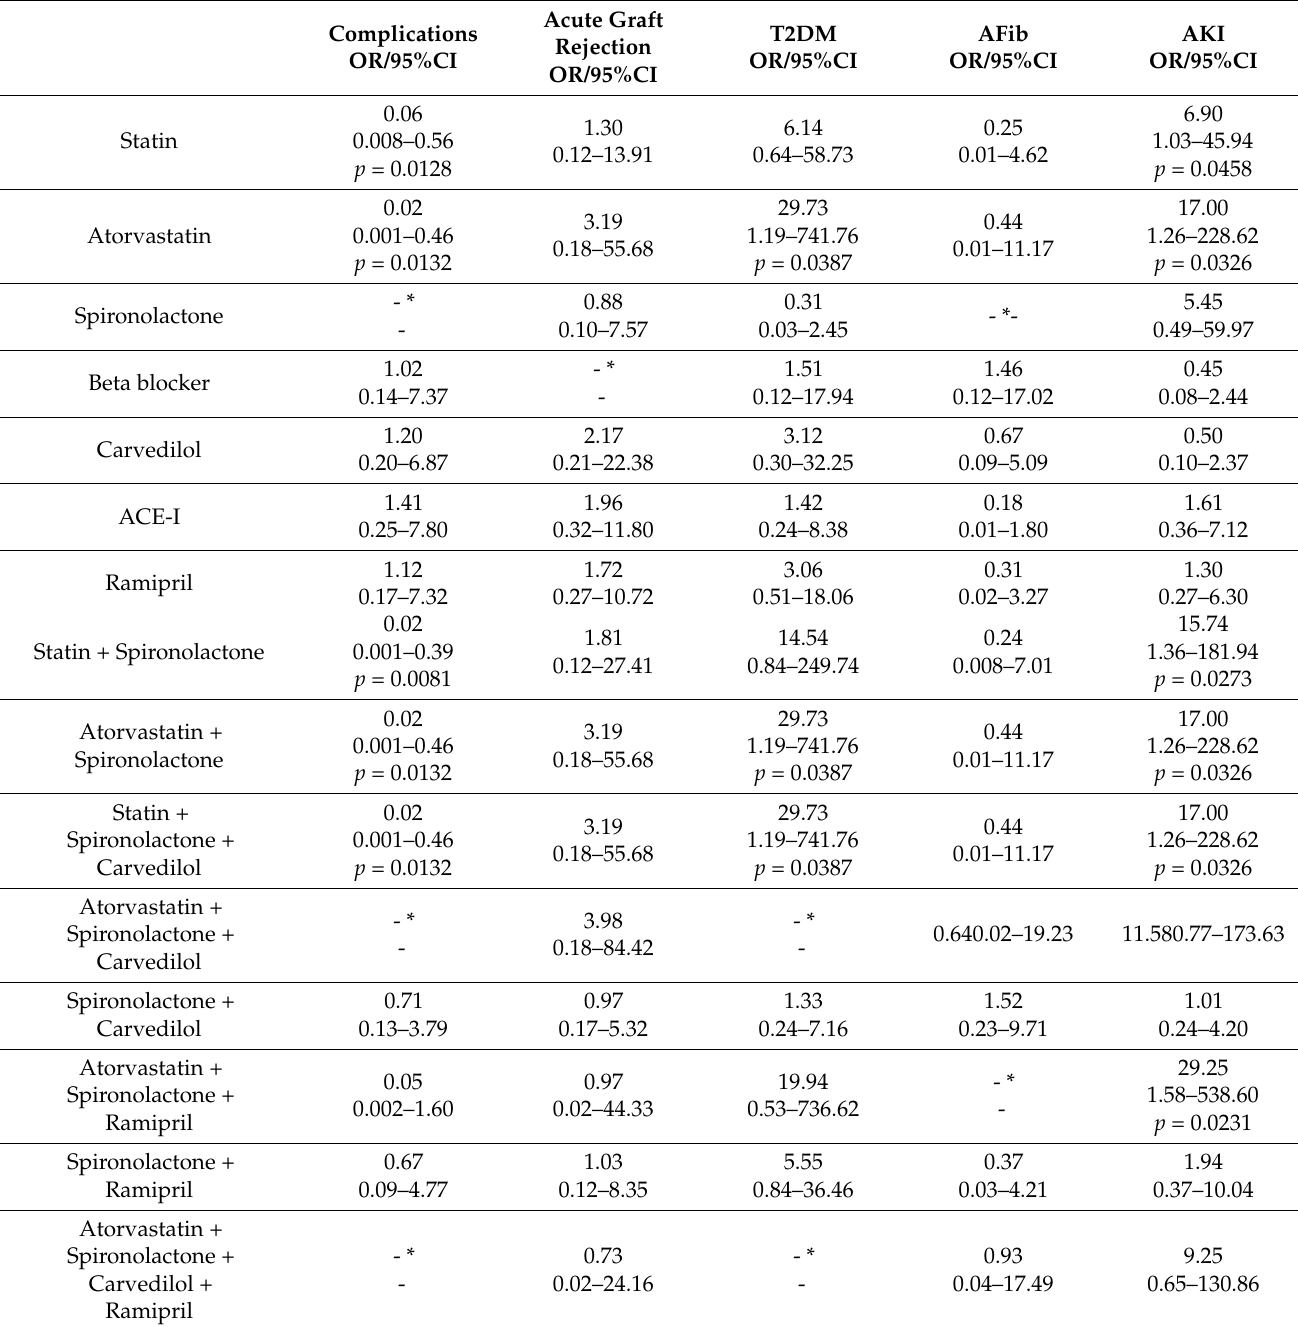
Table 3. Association between drug therapy and 2-month presence of postoperative complications of any cause/specific type of